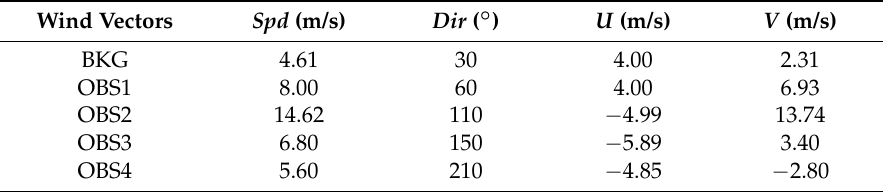
Table 2. The remaining components after quality control for the two assimilation methods.